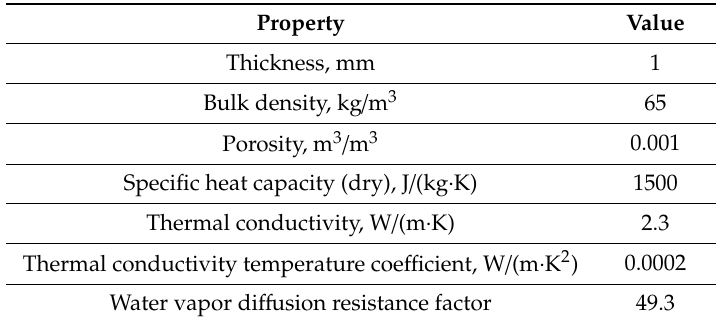
Table A11. SBP property data.